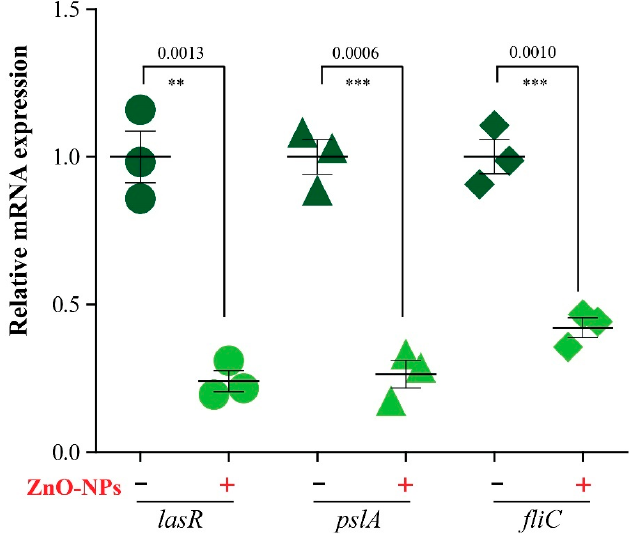
Figure 3. The effect of ZnO-NPs on the relative gene expression of biofilm genes ( lasR , fliC , and pslA ). The data represent the mRNA expression of each gene relative to 16S rRNA . Results are expressed as Mean ± SEM from three independent experiments. ** p ≤ 0.01; *** p ≤ 0.001.